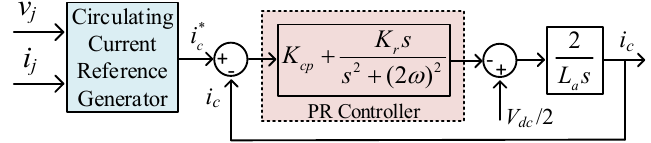
Figure 5. The circulating current control of the